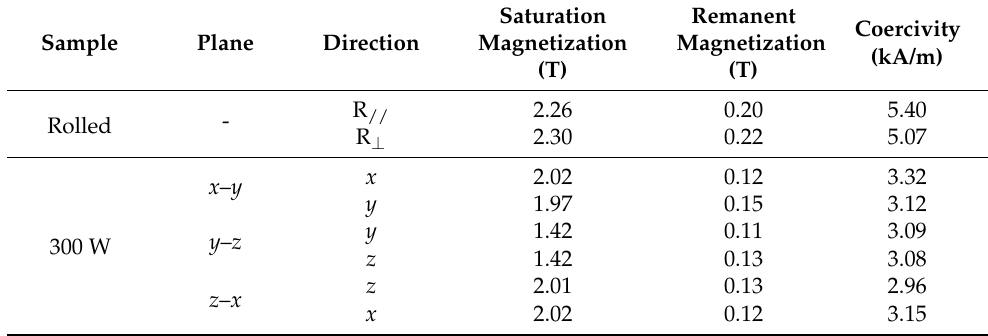
Figure 5. Microstructure features obtained via EBSD analysis; each figure shows the KAM map and IPF map for ( a ) rolled, ( b ) bulk − 300 W ( x – y plane), and ( c ) bulk − 300 W ( y – z plane) samples; high- resolution KAM map and IPF map for ( d ) rolled, ( e ) bulk − 300 W ( x – y plane), and ( f ) bulk − 300 W ( y – z plane) samples. Table 3. Summary of magnetic